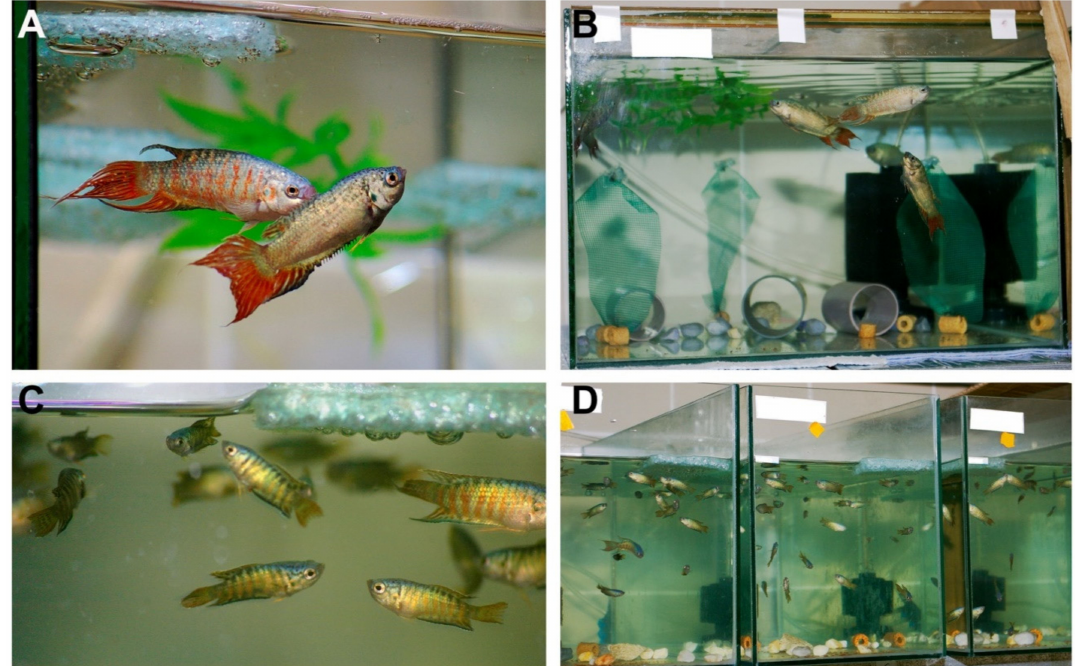
Figure 1. Housing conditions for paradise fish. ( A ) Adult, sexually dimorphic paradise fish pair. Female in the front, male in the back. ( B ) Adult paradise fish are housed at ~1 fish per 3 L water stocking densities, in covered, environmentally en-riched aquariums. ( C ) Adolescent (~4 months post-fertilization (mpf)) fish, with not fully developed sexual dimorphism, can be stocked at higher densities. ( D ) Housing conditions of juvenile paradise fish (~2 fish per 1 L of water). Photo credit: Anita